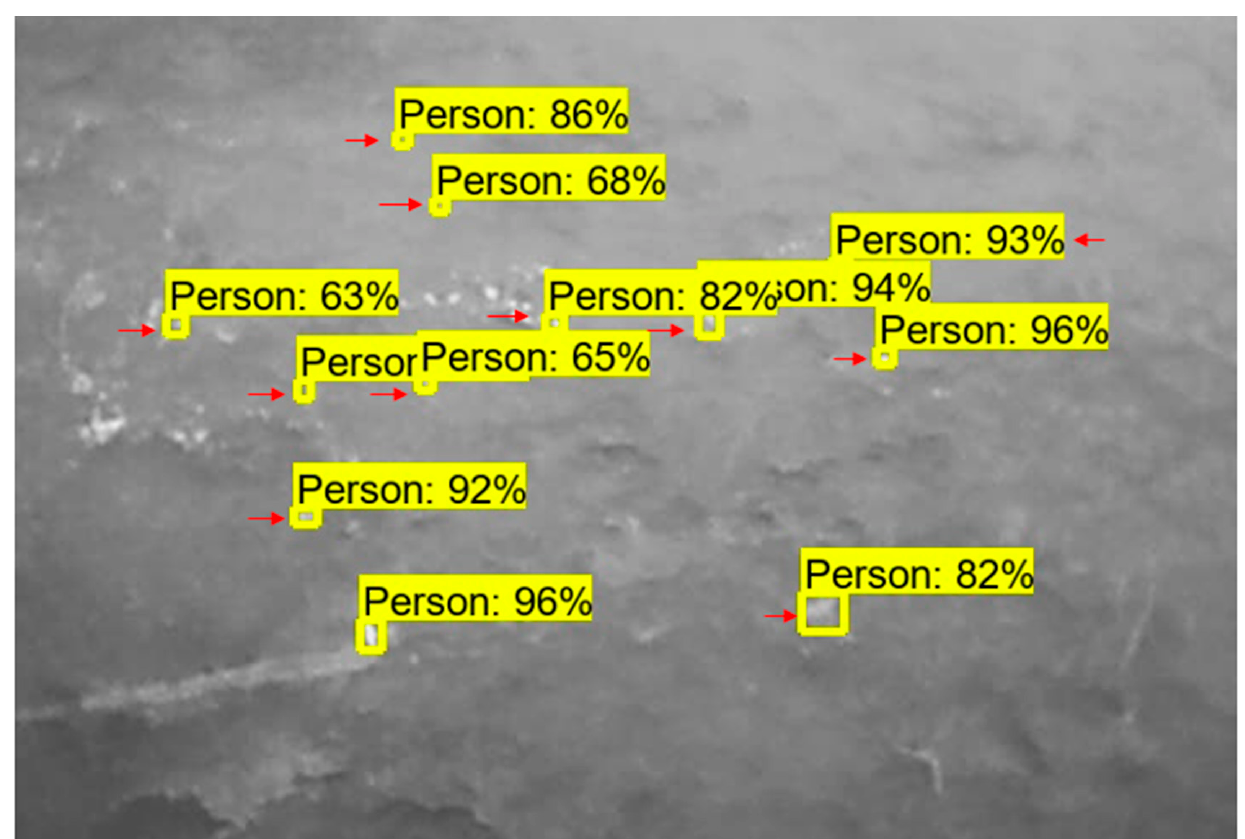
Figure A3. Thermal images showing the false positives caused by hot ground and rocks. The red arrows indicate the false positives.